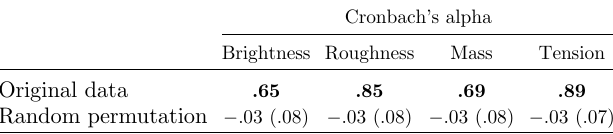
Figure 3. The thick black line represents the mean of the pro fi les within each cluster. The 1st cluster grouped pro fi les that increased in the end, the 2nd cluster featured inverted U pro fi les, the 3rd and 4th clusters grouped increasing and decreasing pro fi les Table 1. Comparison between the mean Cronbach ’ s alpha values for each quality of the original data and the 50th and 95th percentile (in parenthesis) Cronbach ’ s alpha values based on 1000 collections of randomly permuted data for each of the 56 time series. All Cronbach ’ s alpha values were deemed statisti- cally signi fi cant since they exceeded the 95th percentile of the 1000 unrelated collections.